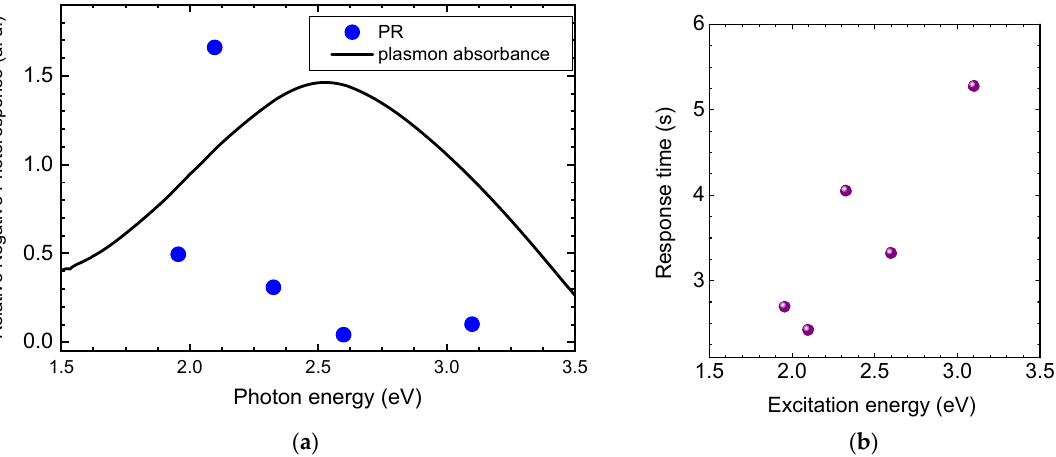
Figure 7. Comparison between photoconductivity behavior for different excitations. ( a ) The negative photoconductivity decreases when the excitation energy is near the surface plasmon resonance from Ag clusters measured by optical absorbance. ( b ) The response times present a systematic increase when LED energies rise.